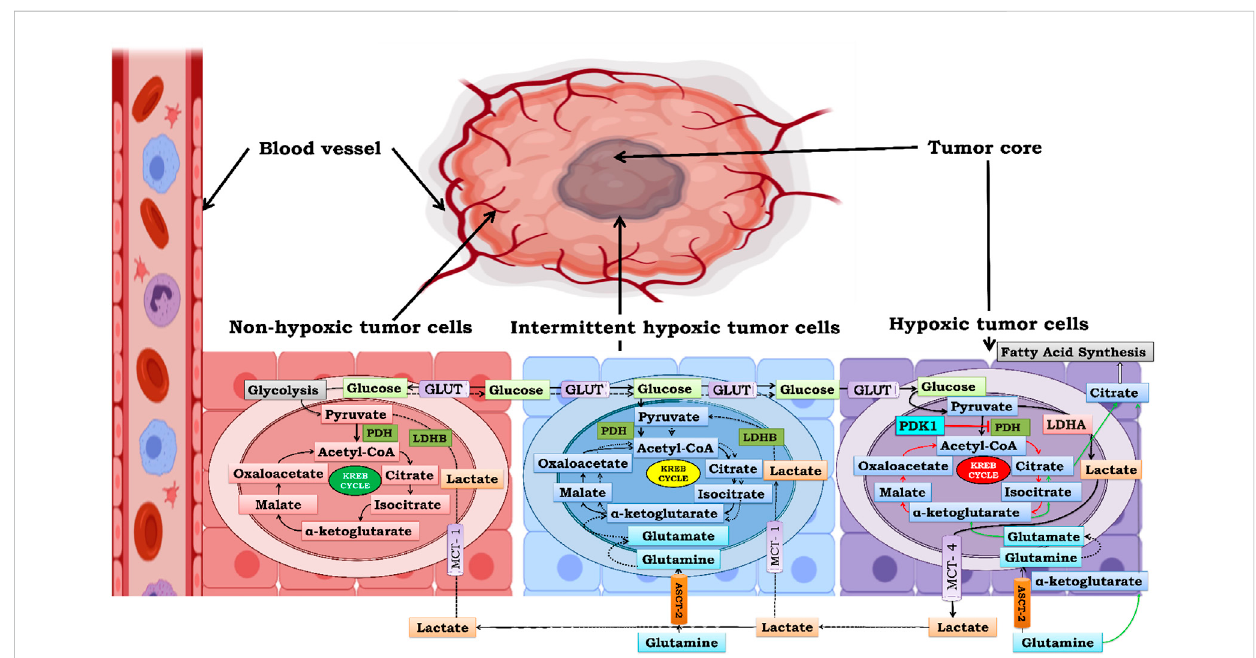
Metabolic Symbiosis under gradedoxygento produce ATP.Bioenergeticsinvolvedinsolidtumor ishighly complex. Cells which are closedto blood vesselshavenormalsupplyofoxygenandglucosethereforeobtainenergythroughglycolysisandkrebcycleinitiallybutasthesizeofthetumorincreases the demand of glucose increases more and more to compensate for this ever increasing demand of glucose there is an upsurge in MCT-1 expression in non-hypoxic cells and they take up exogenous lactate from extracellular tumor microenvironment and convert it to pyruvate by the action of enzyme lactate dehydrogenase B (LDHB). and further this extemporaneously generated pyruvate is utilized to gain energy through Kreb cycle thus sparing glucose for utilization by hypoxic areas which are far from blood vessels. Second in line are intermittently hypoxic cells which utilize both exogenous lactate as well as oxidative glutamine metabolism for energy requirement. Ultimately the core of tumor is formed by severely hypoxic cells which lack access to both blood and oxygen therefore glycolysis is the only source for energy replenishment and therefore undergo rapid glycolysis and generate huge amount of lactate resulting in lactic acidosis. Therefore, in order to survive cancer cells, excrete this lactate out of the cell. This excreted lactate serves as pool of extracellular lactate which can be taken by non-hypoxic and intermittent hypoxic cells for energy production. Hence this cycle goes on and on leading to increase in tumor mass by rapid cellular proliferation and